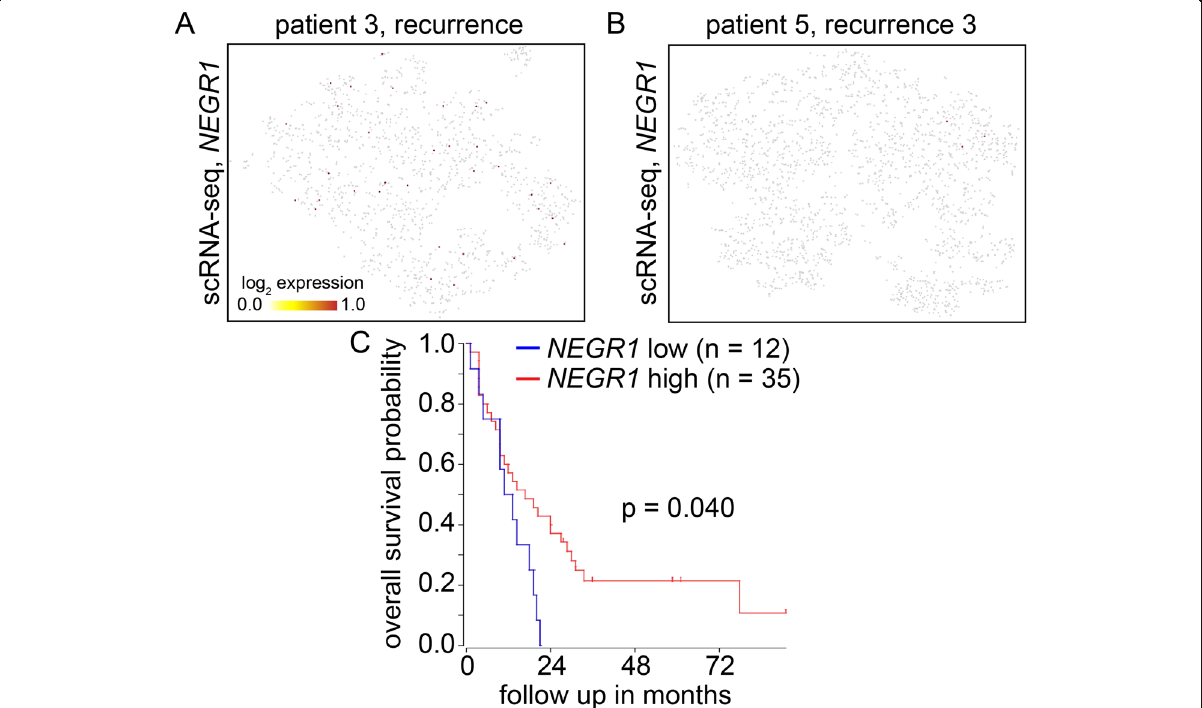
Fig. 2 Single cell RNA-sequencing of NEGR1 expression levels. a . tSNE plot showing single cell RNA-sequencing data illustrates NEGR1 transcription levels in a xenograft derived from recurrence one of patient 3. b . tSNE plot showing NEGR1 transcription levels in single cell RNA-sequencing datasets generated from a xenograft derived from the third recurrence of patient 5. c . A Kaplan-Meier Curve for patient populations with either high or low expression of